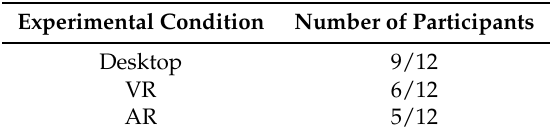
Table 5. Number of Participants that Repeated the First Presented Concept at Least Once.